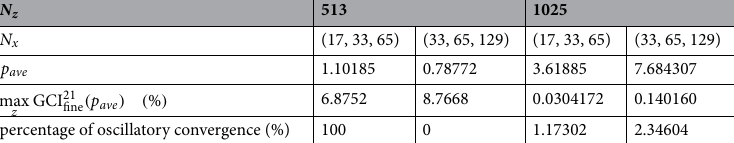
Table 1. The resolution test is examined for several grids N x points in x - and z -directions, respectively. All estimation is made at y points in z